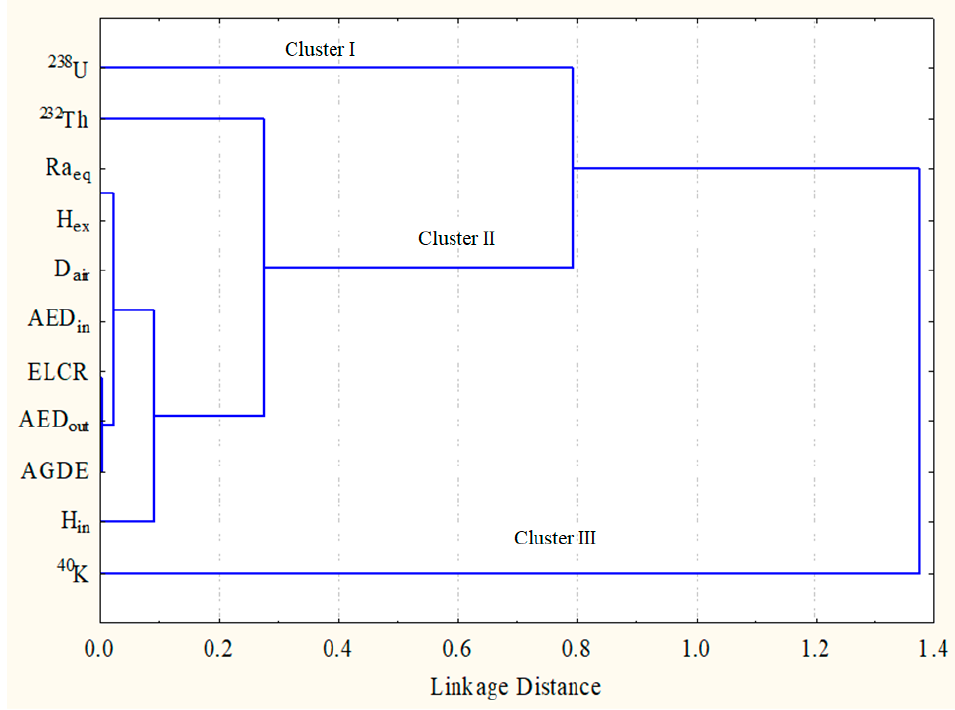
Figure 5. The clustering analysis of the radiological parameters in studied area.